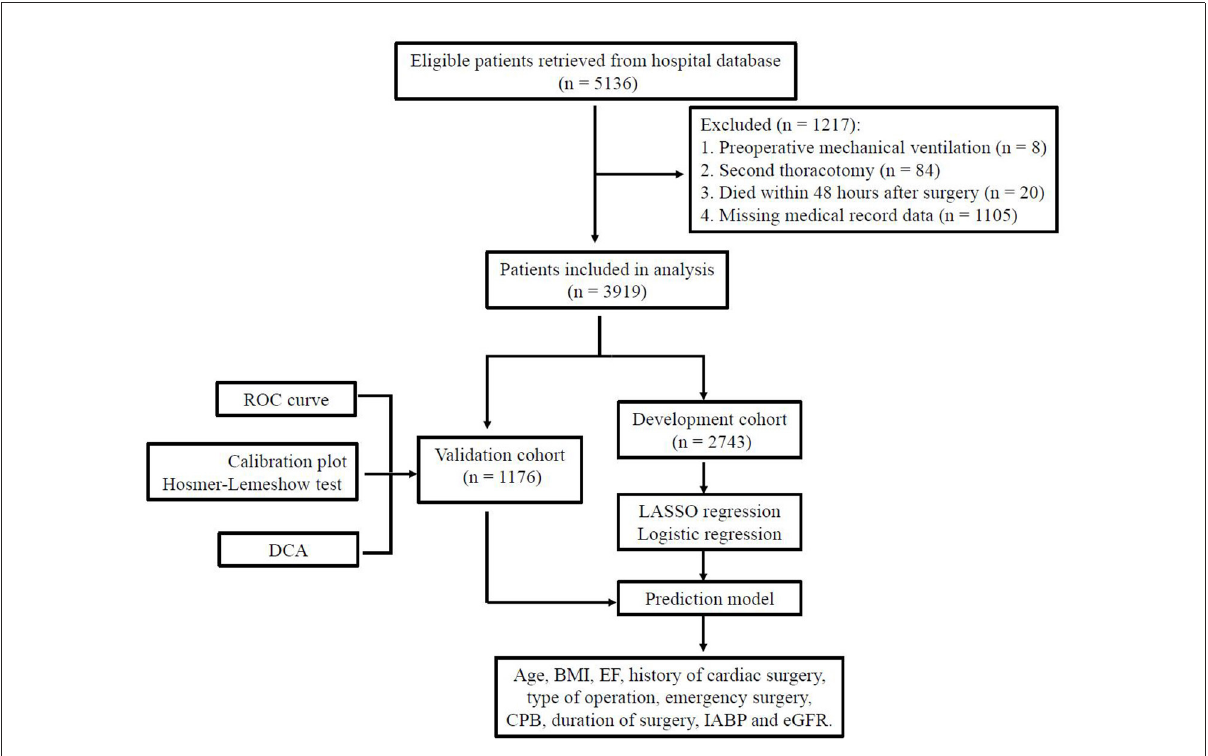
FIGURE1 The flowchart of study design and data